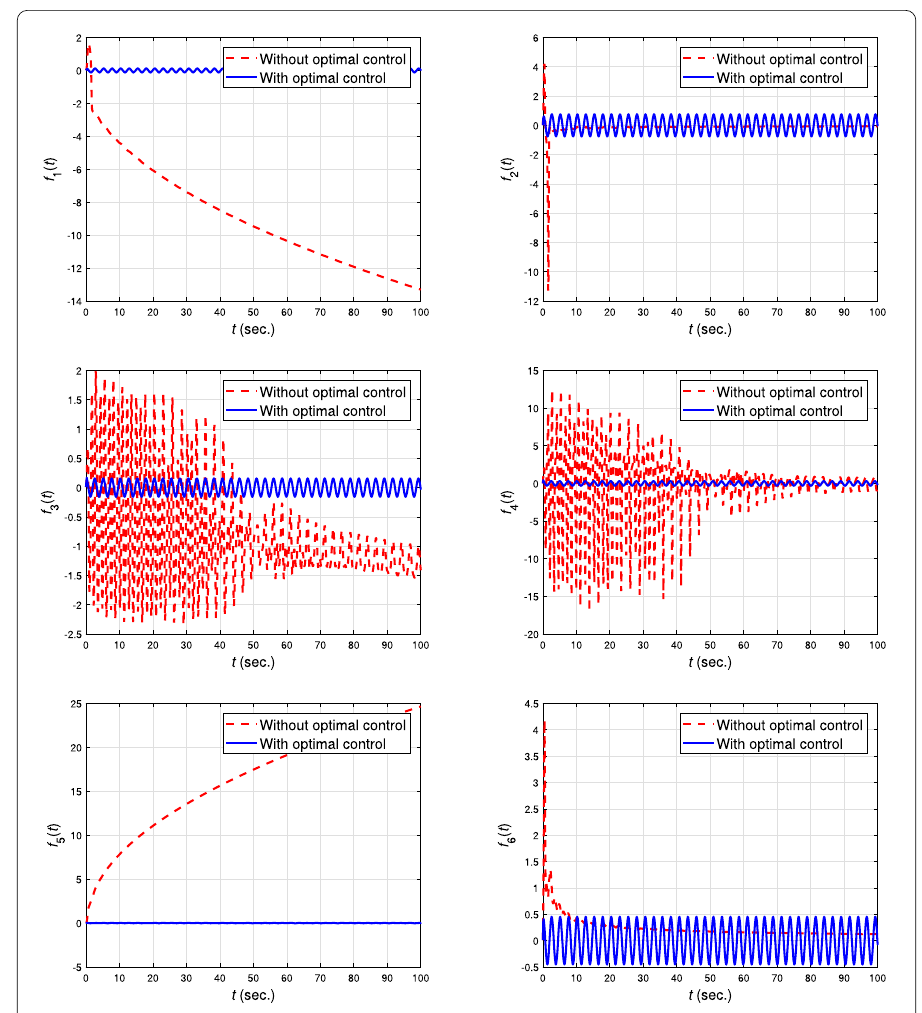
Figure 5 The state variables of the integer-order cardiac conduction system (2) in the absence and the presence of the proposed optimal controller